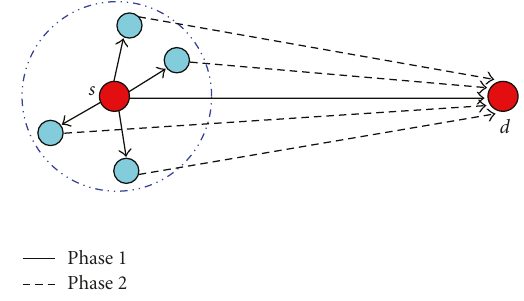
Figure 1: Cooperative communication